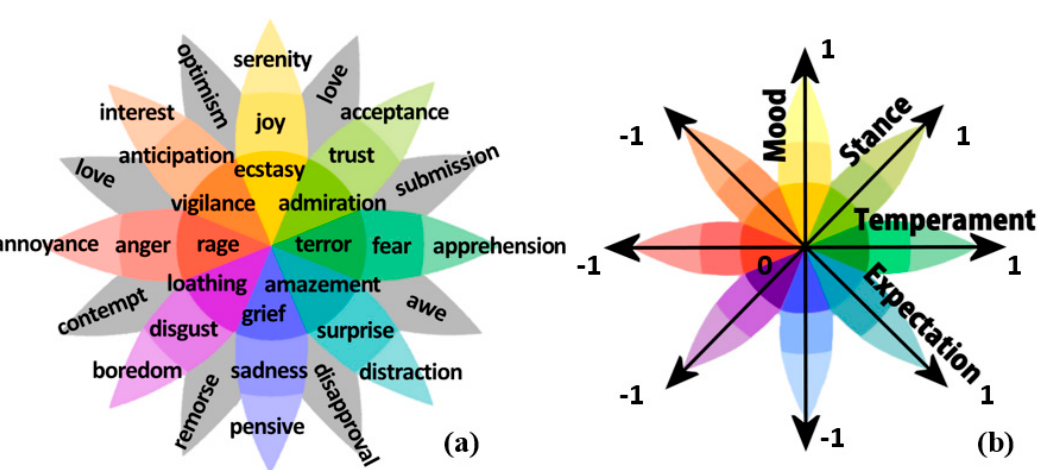
Figure 3. Plutchik’s Wheel of emotions ( a ) and its parametric implementation ( b ). Conceptually, in ( b ) the higher intensity of each emotion corresponds to the tip of the leaves, with the zero located in the center, rather than featuring the highest intensity in the center, like in ( a ), in order to make all zeroes coincide in a single point.